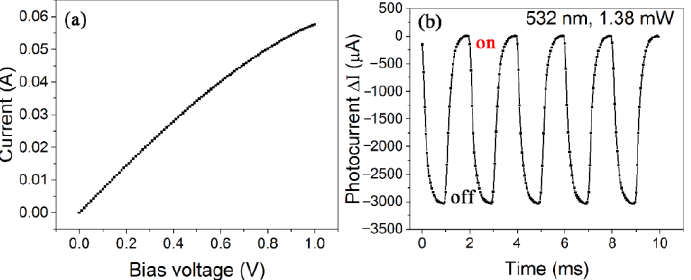
Figure 6. ( a ) I – V characteristic curve, whose linear range was extended to 0.8 V; ( b ) Photoresponse curve under 532 nm laser illumination in air; bias voltage was 0.8 V. The dark current was subtracted.